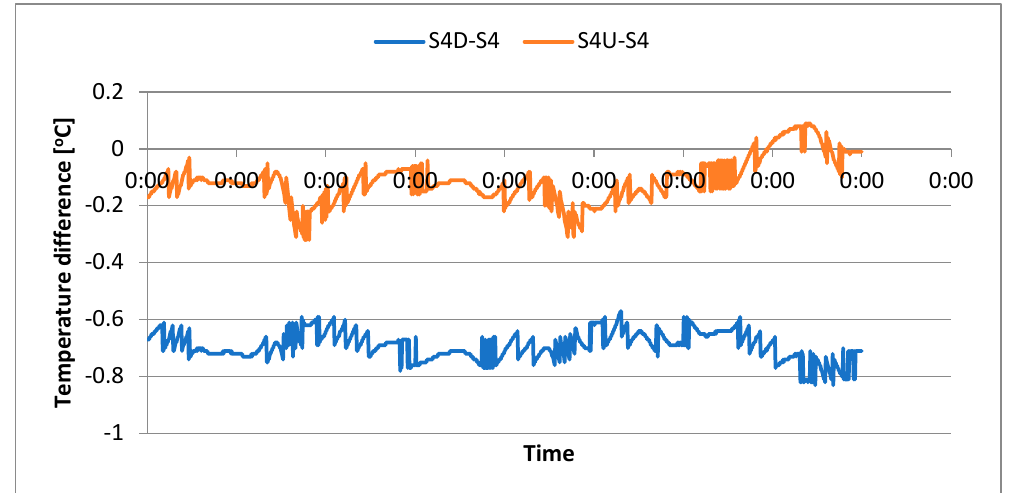
Figure 6. Heat fluxes in the considered wall.